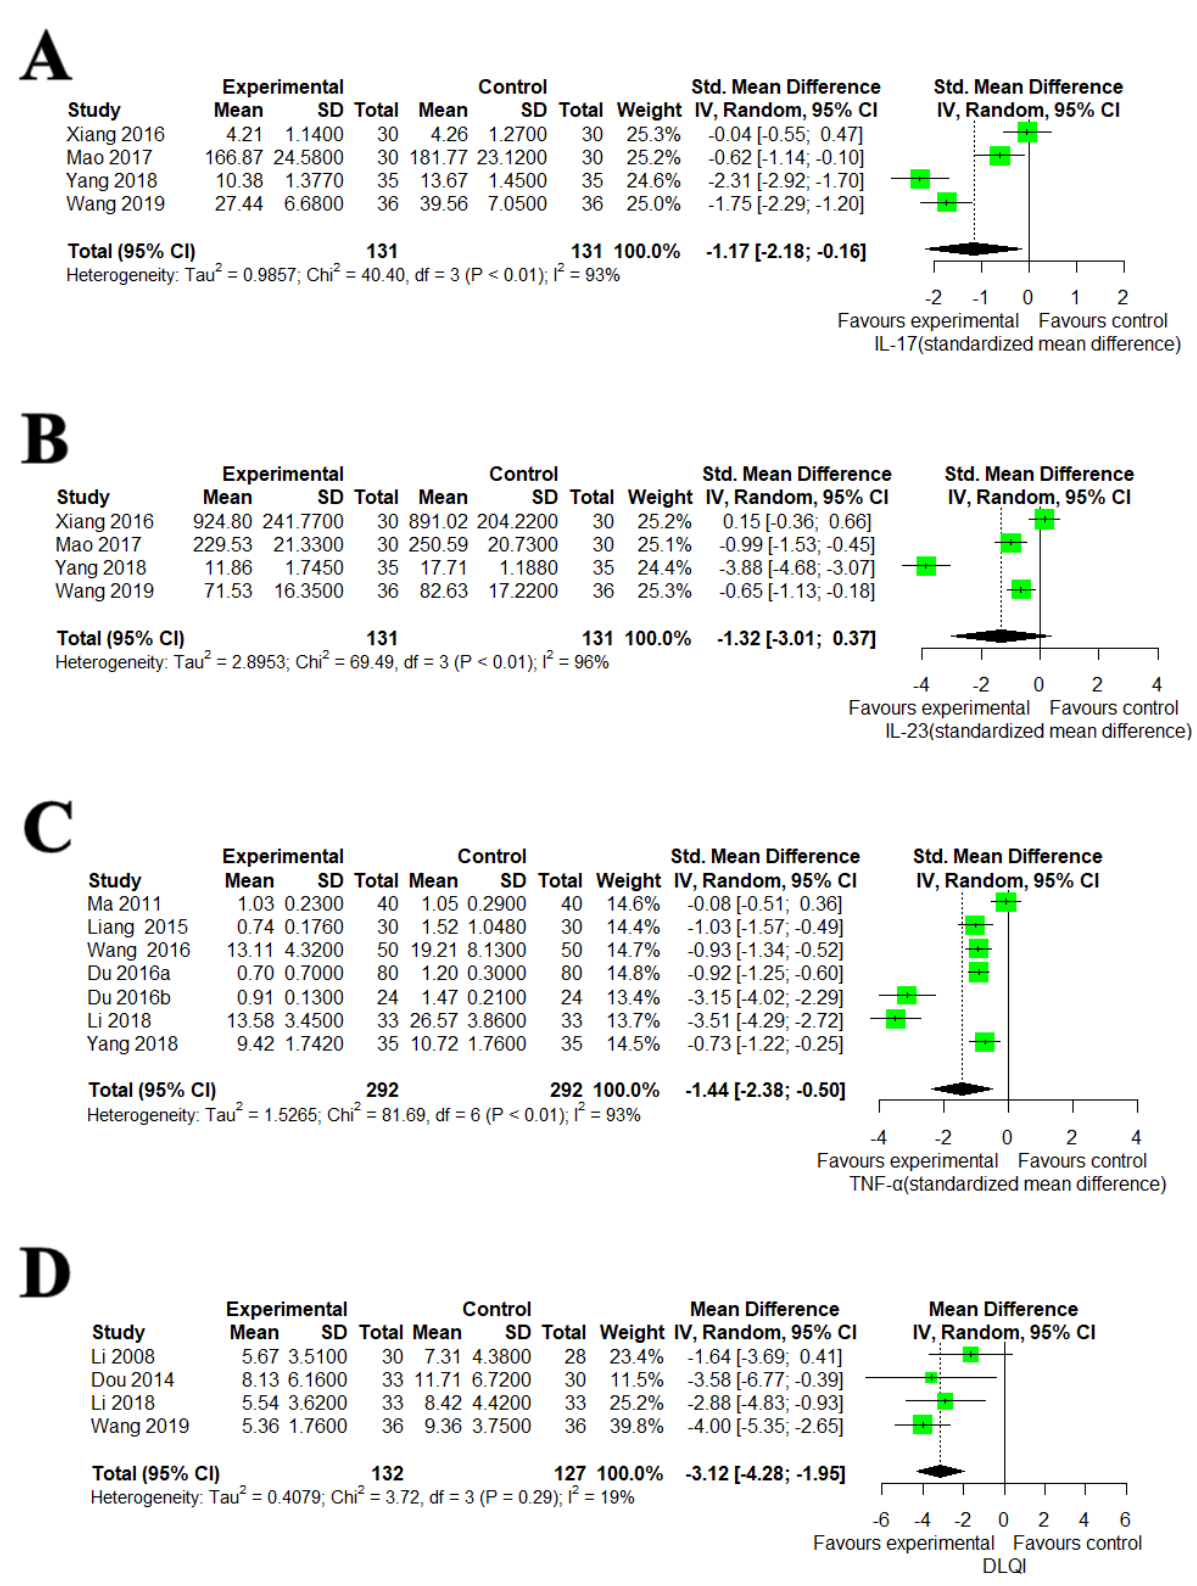
Figure 5. ( A ) Forest plot of the trials that compared EAHM with CM for IL-17, ( B ) forest plot of the trials that compared EAHM with CM for IL-23, ( C ) forest plot of the trials that compared EAHM with CM for TNF- α , ( D ) forest plot of the trials that compared EAHM with CM for